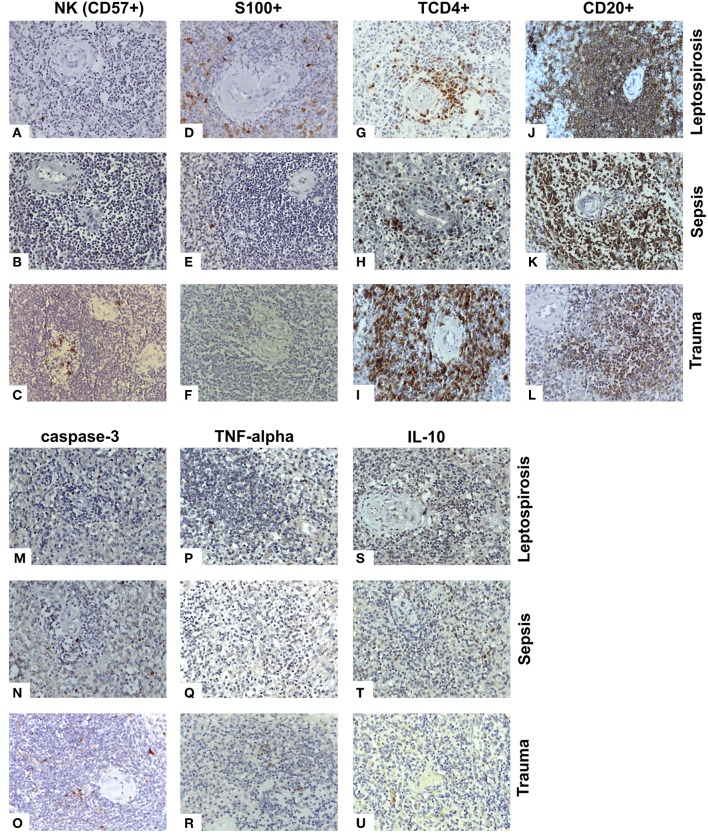
Antigen expression for cell receptors, cytokines and apoptosis in the white pulp of the spleens from fatal cases of Leptospirosis with pulmonary hemorrhage and shock. (A–C) NK cells (CD57+) were present at lower levels in the leptospirosis and sepsis groups as compared to the control group. (D–F) The S100 cells were higher in the leptospirosis group than the sepsis and control groups. (G–I) The TCD4+ cells were in lower quantity in the leptospirosis and sepsis groups than in the control group. (J–L) Both leptospirosis and sepsis groups had more CD20+ cells than patients with control in the white pulp. (M–O) Cleaved caspase 3 positive (apoptotic) cell levels were lower in the leptospirosis and sepsis groups than in the control group in the white pulp. (P–R) TNF-α levels were higher in the leptospirosis group as compared to sepsis and control in both the white and red pulps. (S–U) The number of cells expressing IL-10 was greater in leptospirosis and sepsis groups as compared to control in both red and white pulps. Magnification: 400×.